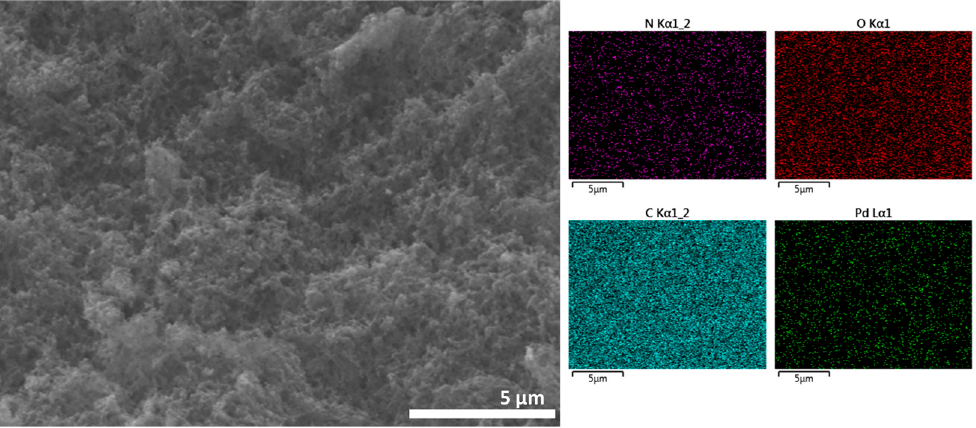
Figure 11. EDX of Pd/Cs.